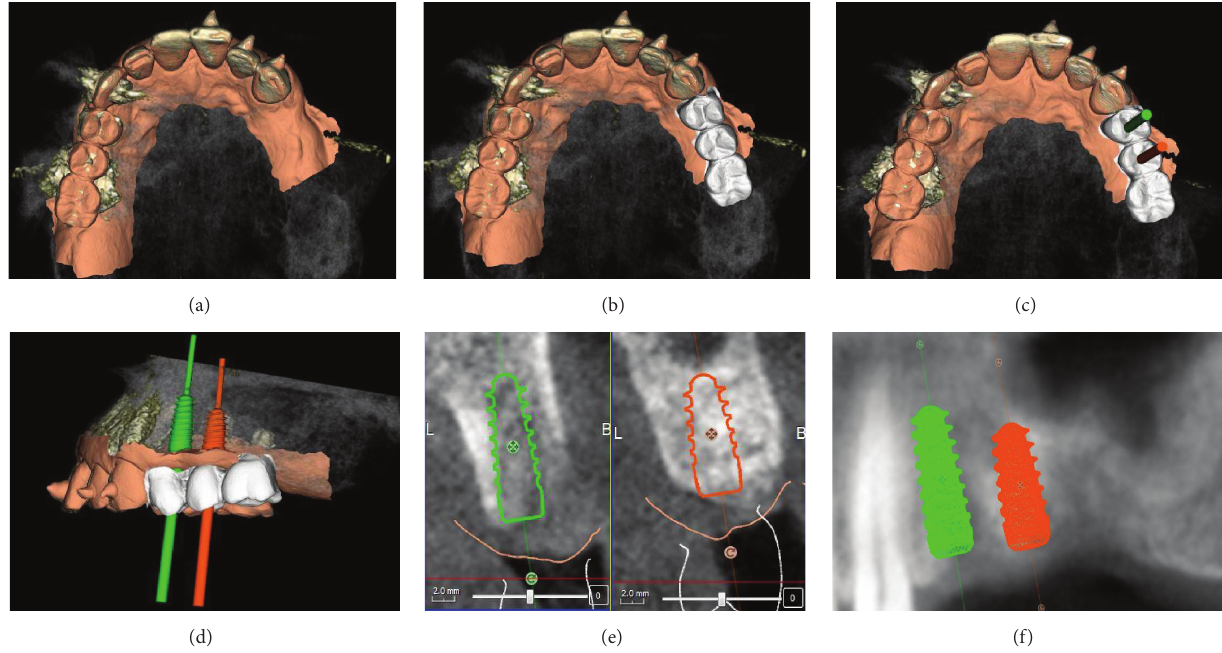
Figure 2: Surgical and prosthetic 3D planning: (a) overlapping of intraoral scan and CBCT; (b) overlapping of intraoral scan and CBCT with modelled provisional restorations; (c) overlapping of intraoral scan and CBCT with modelled provisional restoration and implant planning (occlusal view); (d) overlapping of intraoral scan and CBCT with modelled provisional restoration and implant planning (side view); (e) implant planning (cross sections); (f) implant planning